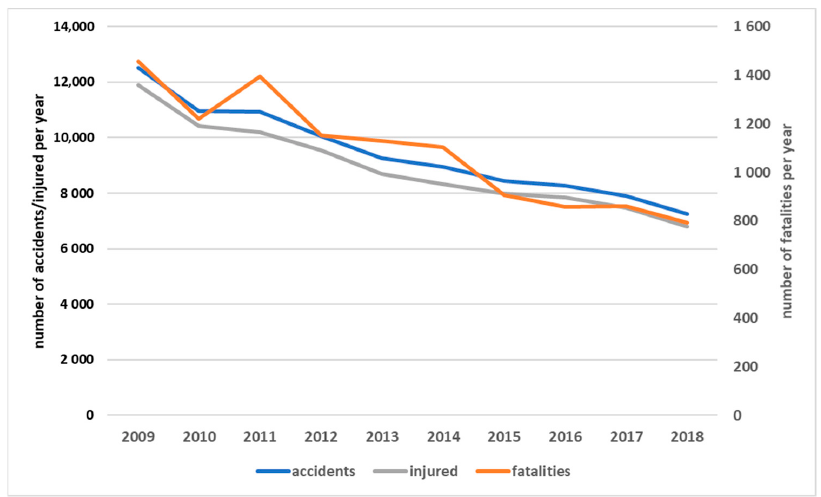
Figure 1. Pedestrian accident and victims in Poland in the years 2009–2018 (based on police’s SEWIK data).